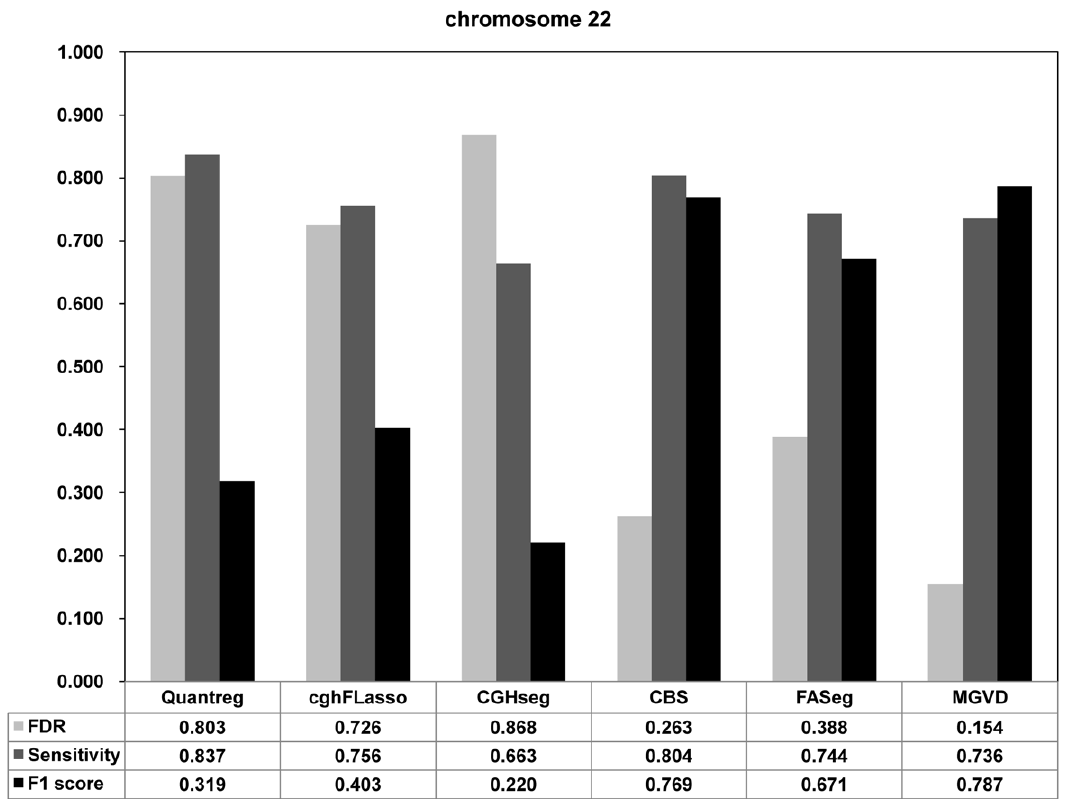
Figure 4. F1 score of five comparing algorithms and MGVD for chromosome 22.